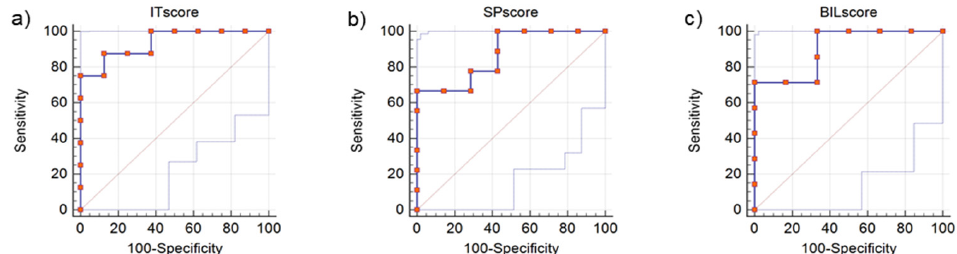
Figure 4. ( a ) ROC curve for the Italian overall score (distinction between DLD diagnosis, n = 8, and absence of pathological scores, n = 8), AUC = 0.938; ( b ) ROC curve for the Spanish overall score (distinction between DLD diagnosis, n = 9, and absence of pathological scores, n = 7), AUC = 0.873; ( c ) ROC curve for the bilingual overall score (distinction between DLD diagnosis, n = 7, and absence of pathological scores, n = 6), AUC = 0.905.